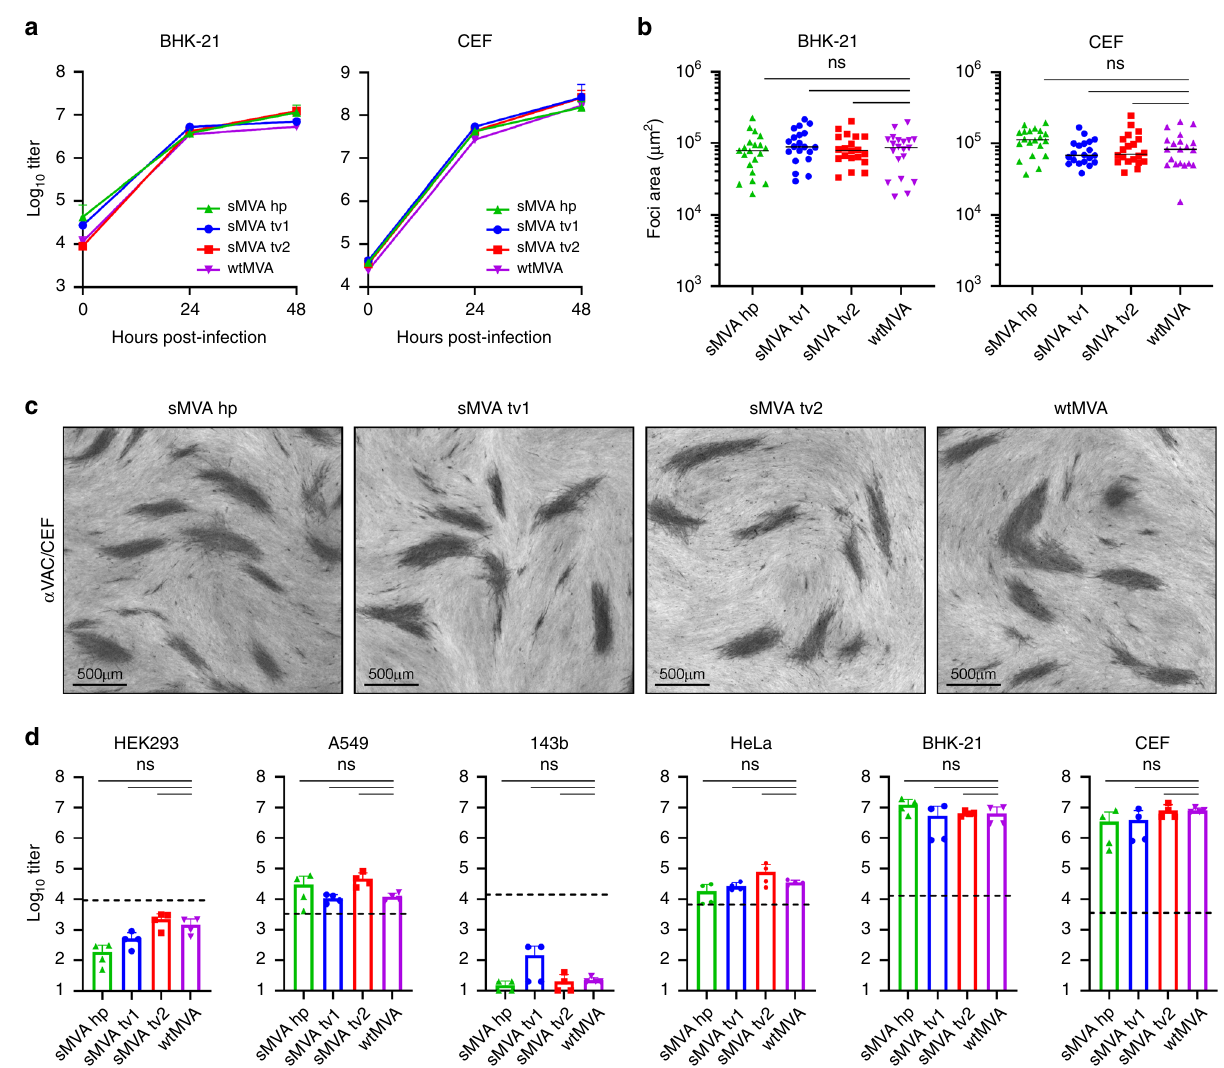
Fig. 2 sMVA replication properties. The replication properties of sMVA, derived either with FPV HP1.441 (sMVA hp) or with FPV TROVAC from two independent sMVA virus reconstitutions (sMVA tv1 and sMVA tv2), were compared with that of wtMVA. a Replication kinetics. BHK or CEF cells were infected in triplicates ( n = 3) for each time point at 0.02 multiplicity of infection (MOI) with sMVA or wtMVA and viral titers of the inoculum and each triplicate infection were determined at 24 and 48 h post infection on CEF. Mixed-effects model with the Geisser-Greenhouse correction followed by Tukey ’ s multiple comparison test were applied; at 24 and 48 h post-infection differences between groups were not signi fi cant ( p > 0.05). b , c Viral foci size analysis. BHK or CEF cell monolayers were infected at 0.002 MOI with sMVA or wtMVA and areas of viral foci ( n = 20) were determined at 24 h post infection following immunostaining with anti-Vaccinia polyclonal antibody ( α VAC). Panel c provides examples of sMVA and wtMVA viral foci following immunostaining of infected CEF. d Host cell range analysis. Various human cell lines (HEK293, A549, 143b, and HeLa), CEF or BHK cells were infected in duplicates ( n = 2) at 0.01 MOI with sMVA or wtMVA and virus titers of each duplicate infection were determined in duplicates ( n = 4 in total) at 48 h post infection on CEF. Dotted lines indicate the calculated virus titer of the inoculum based on 0.01 MOI. Differences between groups in b and d were calculated using one-way ANOVA followed by Tukey ’ s ( b ) or Dunnett ’ s ( d ) multiple comparison tests; ns = not signi fi cant ( p > 0.05). Data in a and d are presented as mean values + SD. Lines in b represent median values. Source data are provided as a Source Data fi commonly used MVA insertion sites located at different positions within the three sMVA fragments. Combinations of modi fi ed and immunization by ex vivo antigen stimulation using immunodo- unmodi fi ed sMVA fragments were subsequently co-transfected minant peptides 38 revealed similar MVA-speci fi c T-cell levels in into FPV-infected BHK cells to reconstitute sMVA SARS-CoV-2 mice receiving sMVA or wtMVA (Figs. 3c, d and S1c, d). These (sMVA-CoV2) vaccine vectors expressing the S and N antigen results indicate that sMVA virus has a similar capacity to wtMVA sequences alone or combined (Fig. 4a, b). In the single recom- in inducing MVA-speci fi c humoral and cellular immunity in binant vectors encoding S or N alone, termed sMVA-S and mice. sMVA-N, the antigen sequences were inserted into the Deletion 3 (Del3) site (Figs. 1b and 4b) 5 . In the double recombinant vectors Construction of sMVA SARS-CoV-2 vaccine vectors . Using encoding both S and N, termed sMVA-N/S and sMVA-S/N, the highly ef fi cient BAC recombination techniques in E. coli 39,40 , full- antigen sequences were inserted into Del3 and the Deletion 2 length SARS-CoV-2 S and N antigen sequences were inserted into